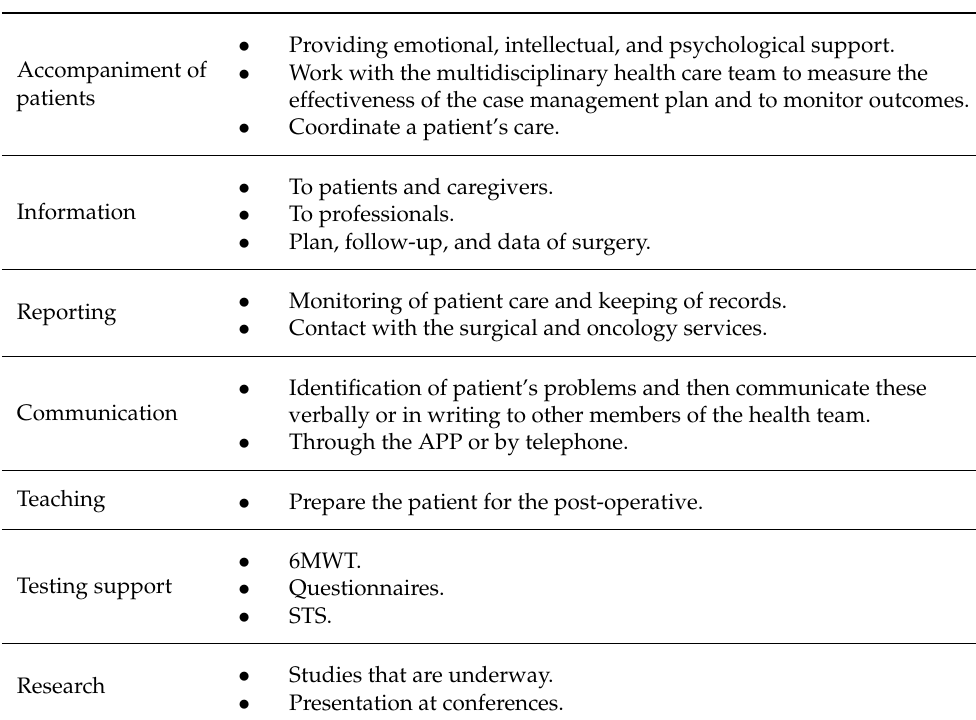
Table 2. Evolution task: nurse/case manager.